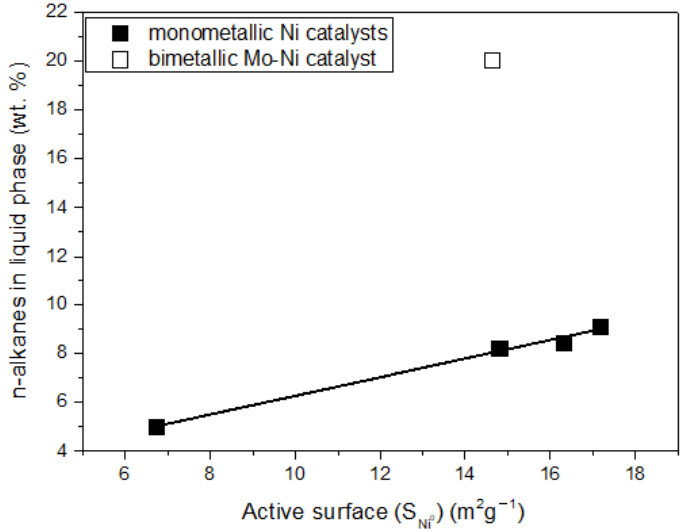
Figure 13. The n-alkanes concentration in the liquid product of the reaction vs. Ni active surface, over both monometallic and bimetallic catalysts.